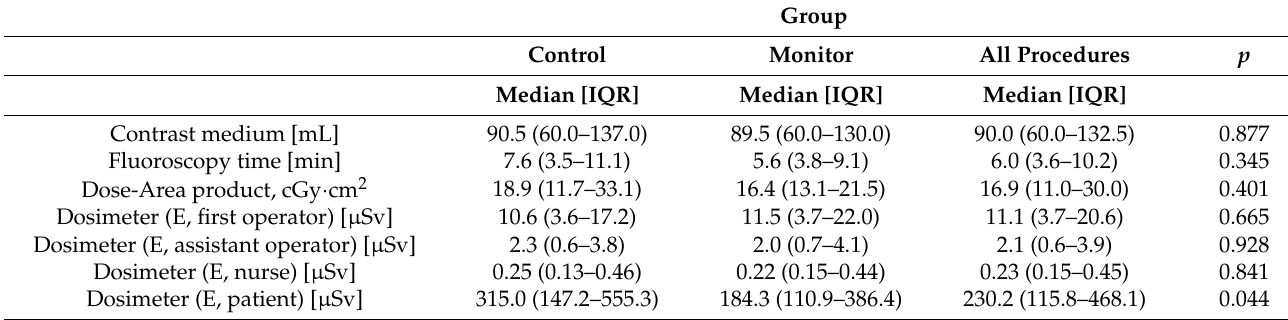
Table 4. Exposure in procedures in patients with BMI >